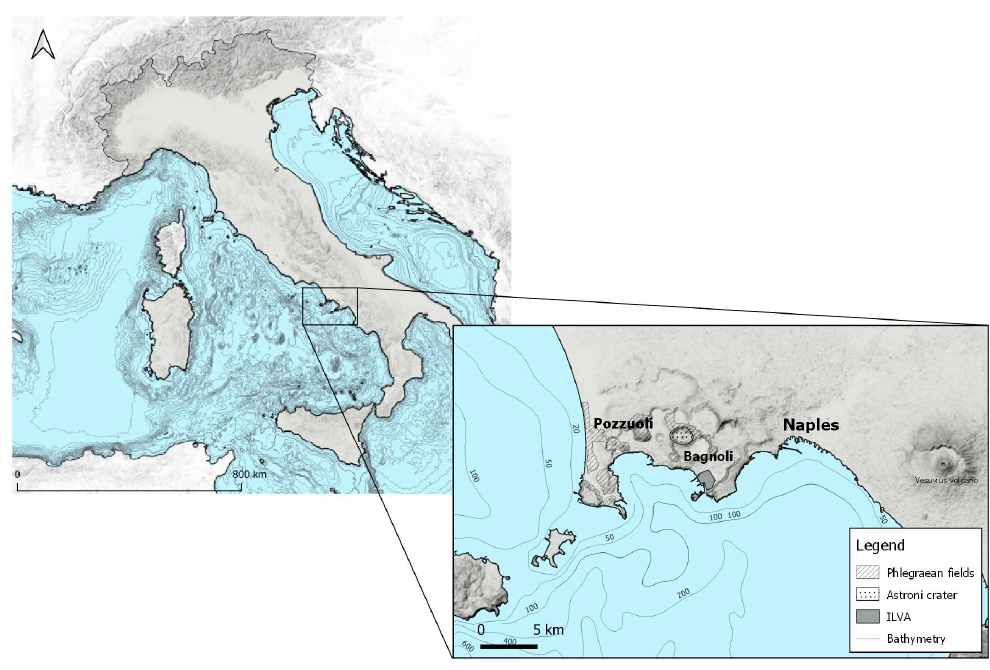
Figure 2. Location of the study area, Bagnoli bay, Naples, Italy.